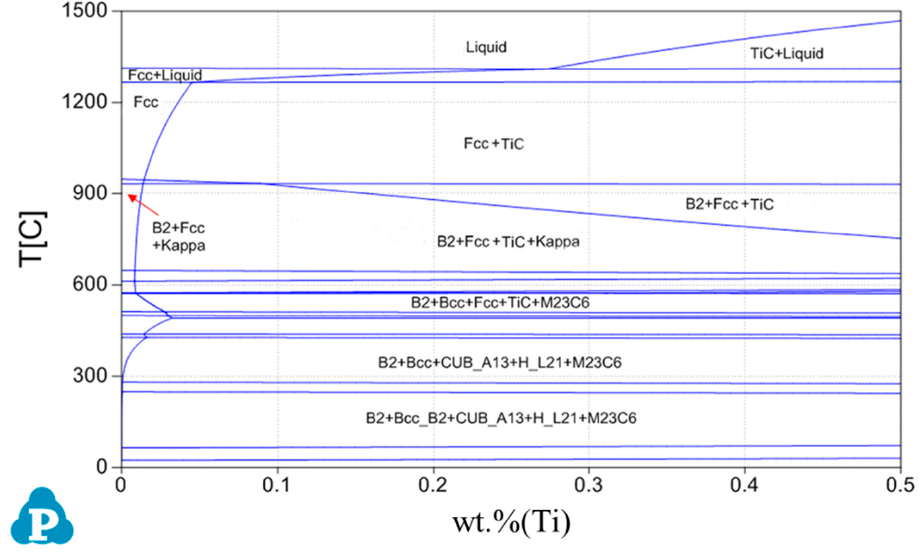
Figure 1. Phase diagram calculation results of Fe-25Mn-9Al-8Ni-1C-xTi alloy.